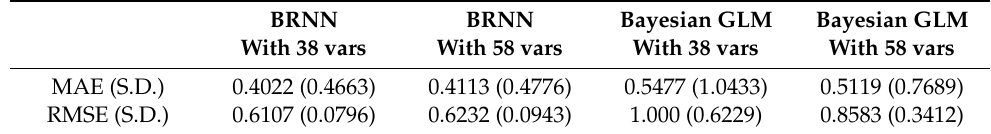
Table 3. MAE and RMSE from 9 iterations of 340 companies.